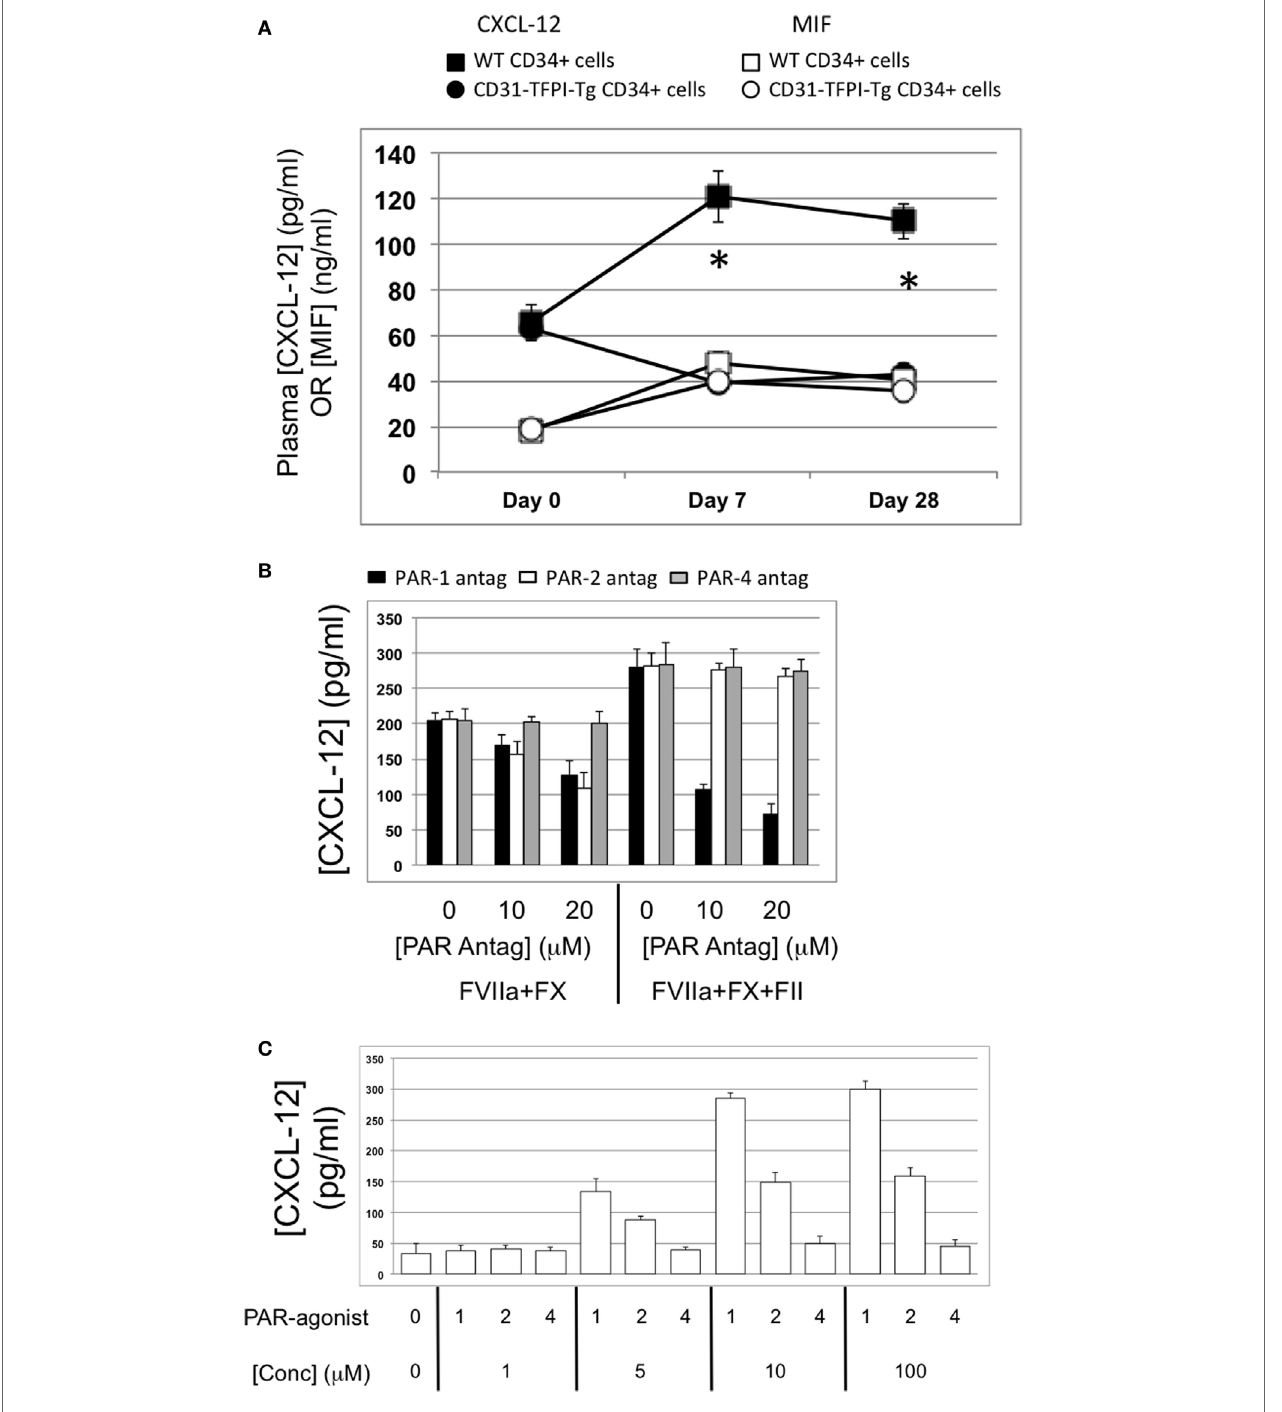
FigUre 11 | Association between plasma CXCL-12 and intimal hyperplasia (IH): CXCL-12 expression is thrombin and angiopoietin-2-dependent. (a) Plasma CXCL-12 (black filled) and migration inhibitory factor (MIF) (white filled) levels post-injury in wild-type (WT) recipients of WT (squares) or CD31-TFPI-Tg (circles) CD34 + cells. *Day 7 and day 28 p < 0.005 WT vs. CD31-TFPI-Tg for CXCL-12. p = NS for all comparisons of MIF. (B) CXCL-12 secretion by WTCD34 + cells (3 × 10 4 /well) after 24 h incubation with either PAR-1 antagonist (black bars), PAR-2 antagonist (white bars), or PAR-4 antagonist (gray bars) at the indicated concentrations for 30 min before addition of FVIIa with FX (both 10 nM) with or without prothrombin (4 nM) and FVa (6 nM) as indicated. All conditions performed in triplicate wells. Error bars indicate SEM. (c) Angiopoietin-2 secretion by WT CD34 + cells (3 × 10 4 /well) after 24-h incubation with PAR-1, -2, or -4 agonists at the indicated concentrations. All conditions performed in triplicate wells. Error bars indicate SEM. Data shown in (B,c) is from WT CD34 + cells. Abbreviations: Csi, control siRNA; Ang-2si, siRNA specific for angiopoietin-2. Experiments repeated at least